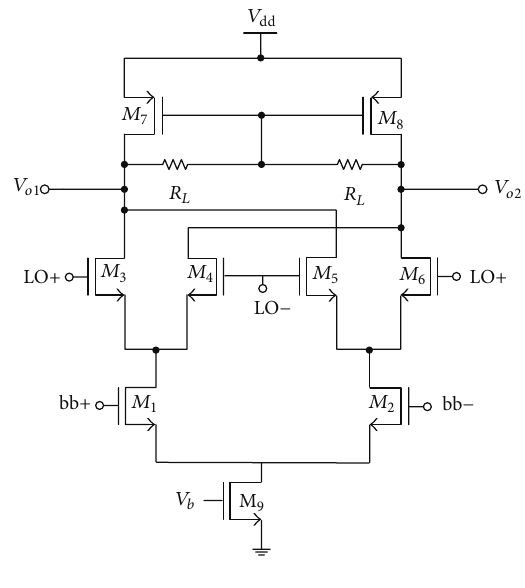
Figure 1: Conventional double-balanced mixer.